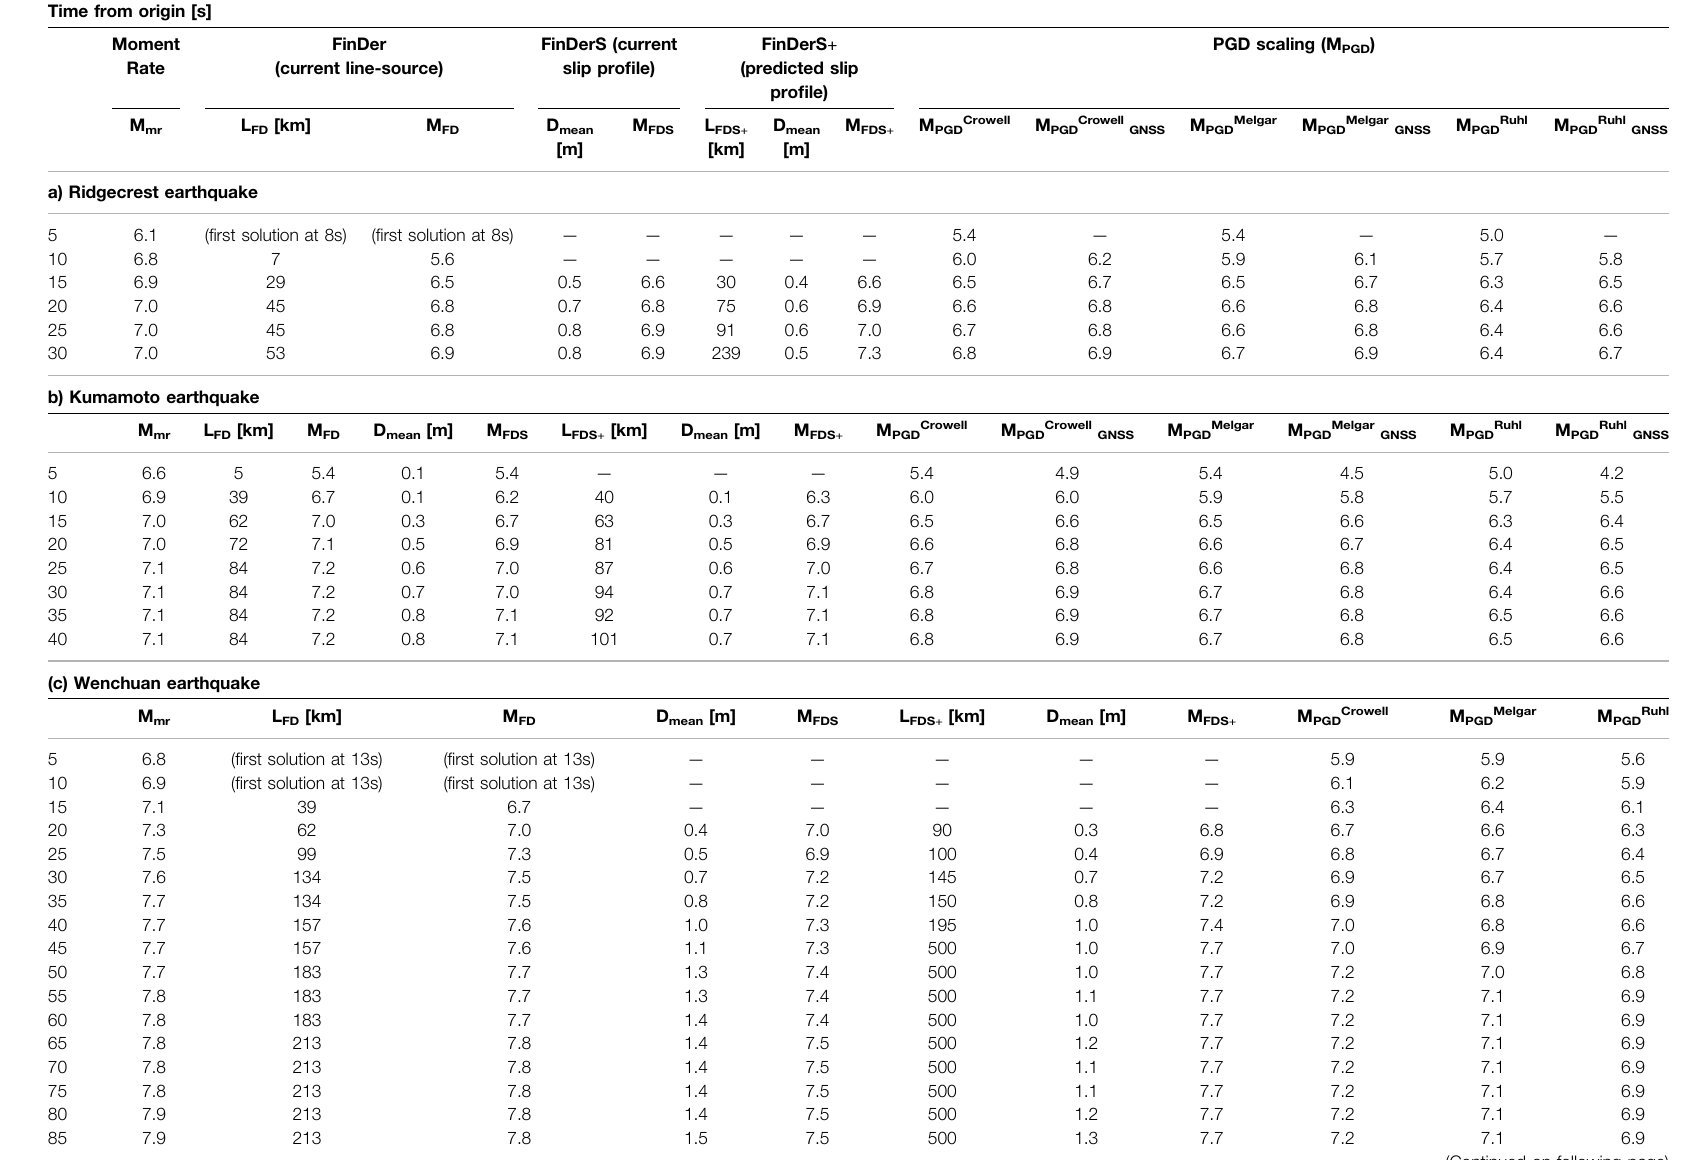
TABLE 2 | Results from FinDer (rupture length, L FD , and magnitude, M FD ), FinDerS (mean slip, Dmean, and magnitude, M FDS , both from fi tted slip pro fi le) and FinDerS+ (predicted fi nal rupture length, L FDS+ , predicted fi nal meanslip,mean,and predicted fi nalmagnitude, M FDS+ )forthea)Ridgecrest, b)Kumamoto, and c)Wenchuanearthquake asafunctionoftime fromoriginfora60 kmstationdistance cutoff. Magnitudes MmrandM PGD are estimated from the USGS moment rate function and empirical PGD-distance relationships (Melgar et al., 2015; Crowell et al., 2016; Ruhl et al., 2019), respectively. Table shows updates in increments of 5